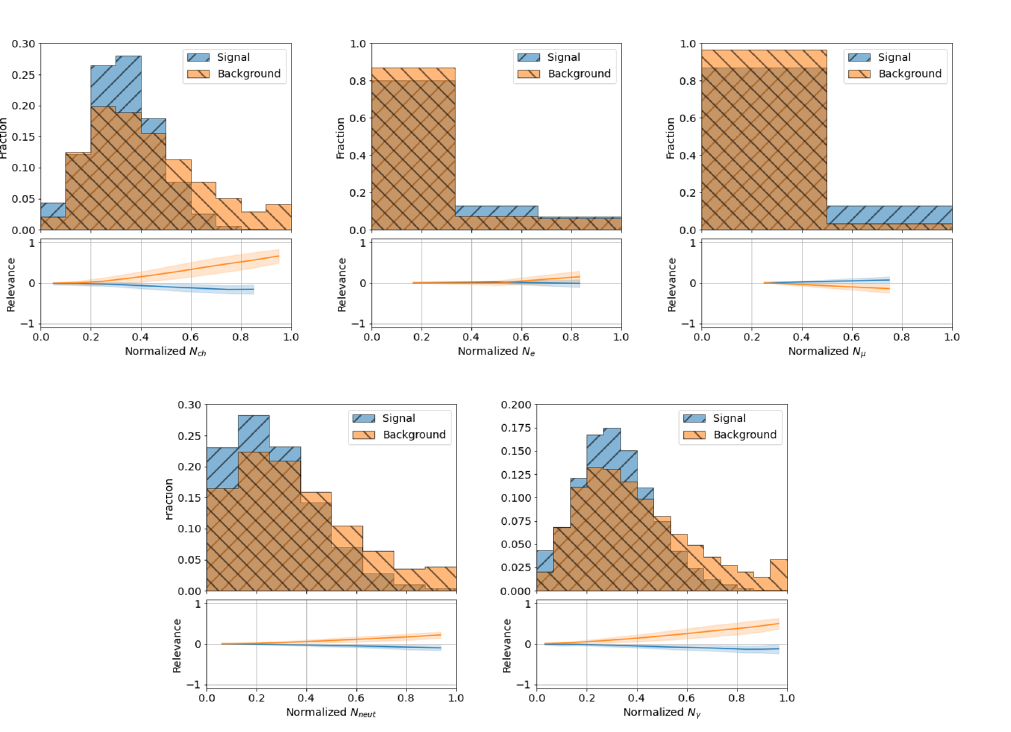
Figure 31. Histograms with profiles of normalized LRP